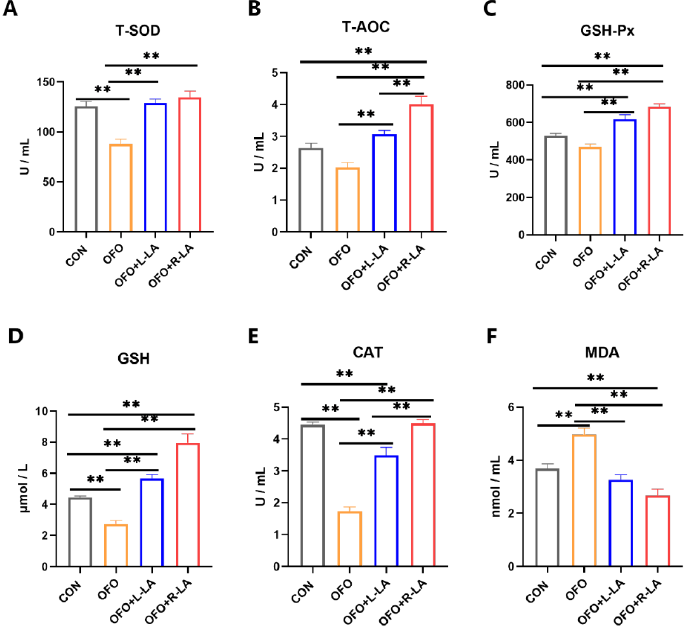
Figure 5. Effect of different treatments on serum antioxidant of laying hens. ( A ) Total superoxide dismutase (T-SOD); ( B ) total antioxidant capacity (T-AOC); ( C ) glutathione peroxidase (GSH-Px); ( D ) glutathione (GSH); ( E ) catalase (CAT); ( F ) malondialdehyde (MDA). ** indicates highly significant differences ( p < 0.01).